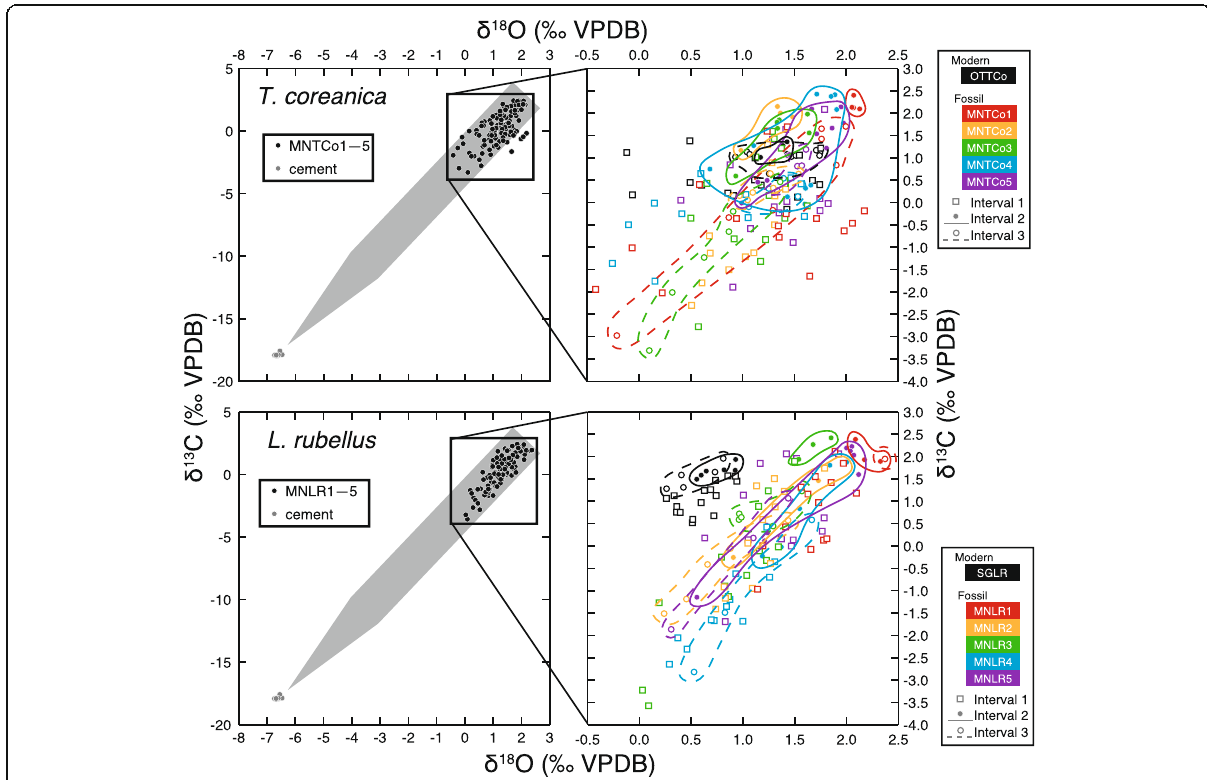
Fig. 7 Cross-plots of δ 13 C versus δ 18 O values of the studied brachiopod shells. The samples were extracted from the modern and fossil T. coreanica and L. rubellus shells. The cement δ 13 C versus δ 18 O values are also